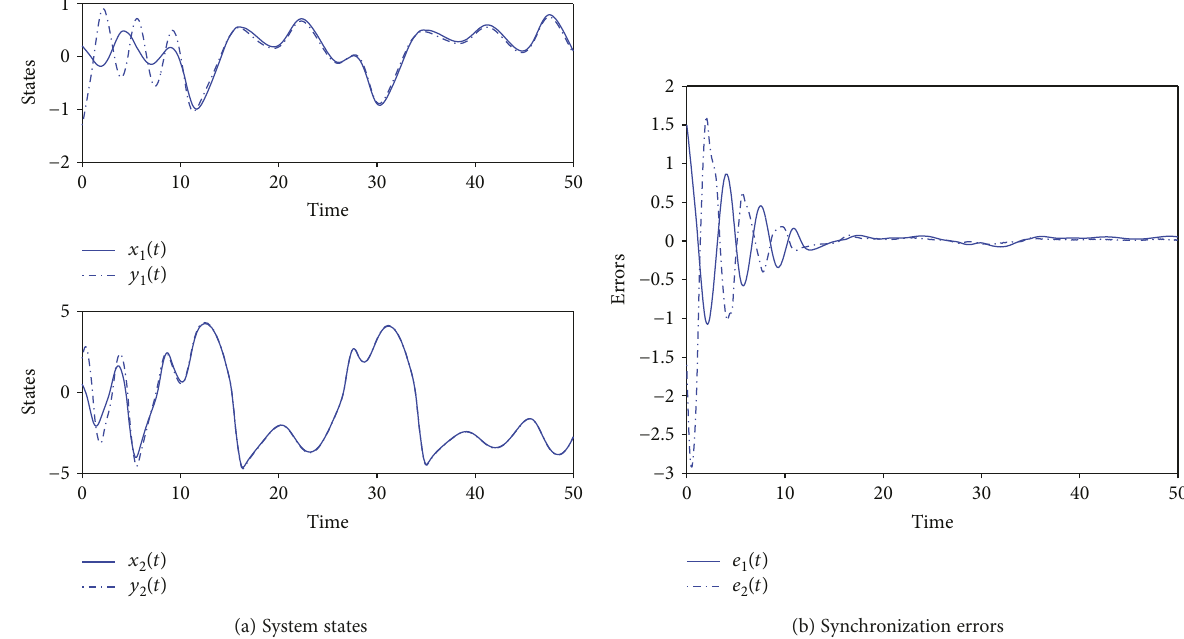
Figure 3: The temporal evolution of each variable and the plot of synchronization errors when the adaptive gains are δ